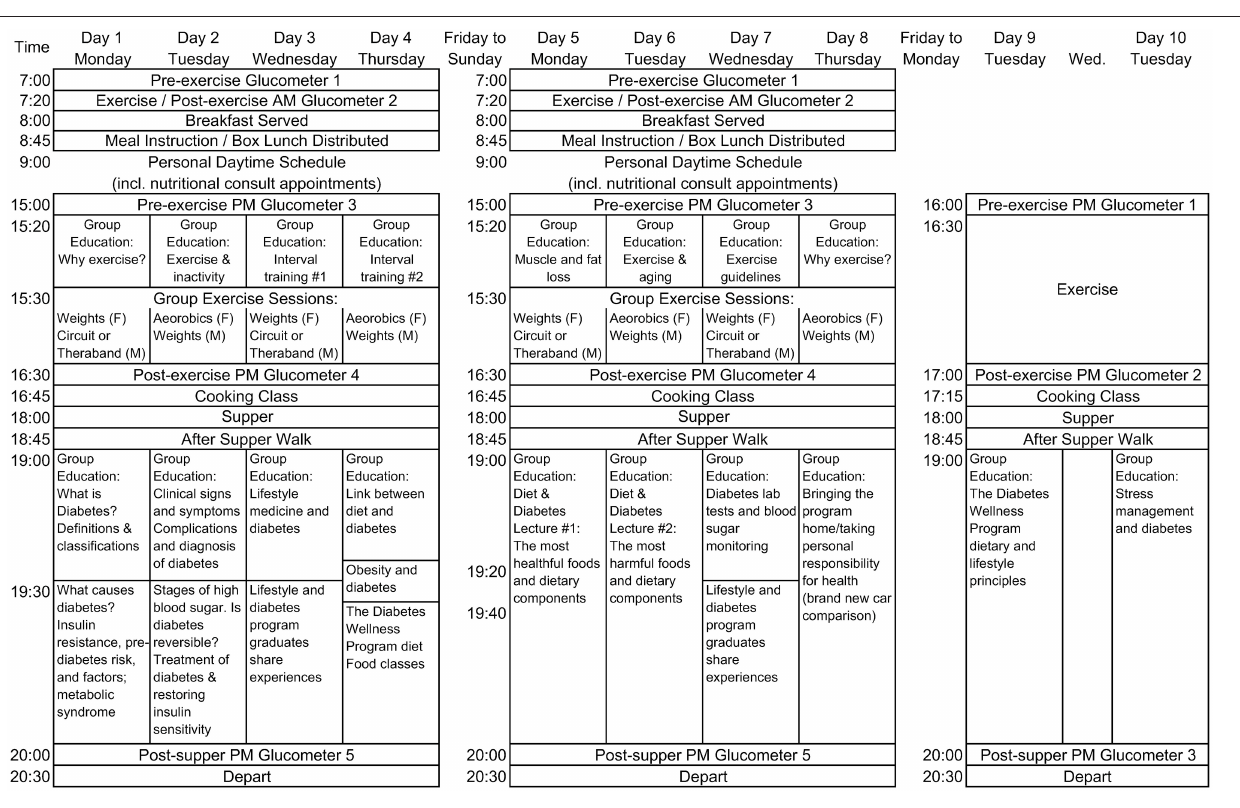
FIGURE 1 | Schedules for the first 3 weeks of the lifestyle